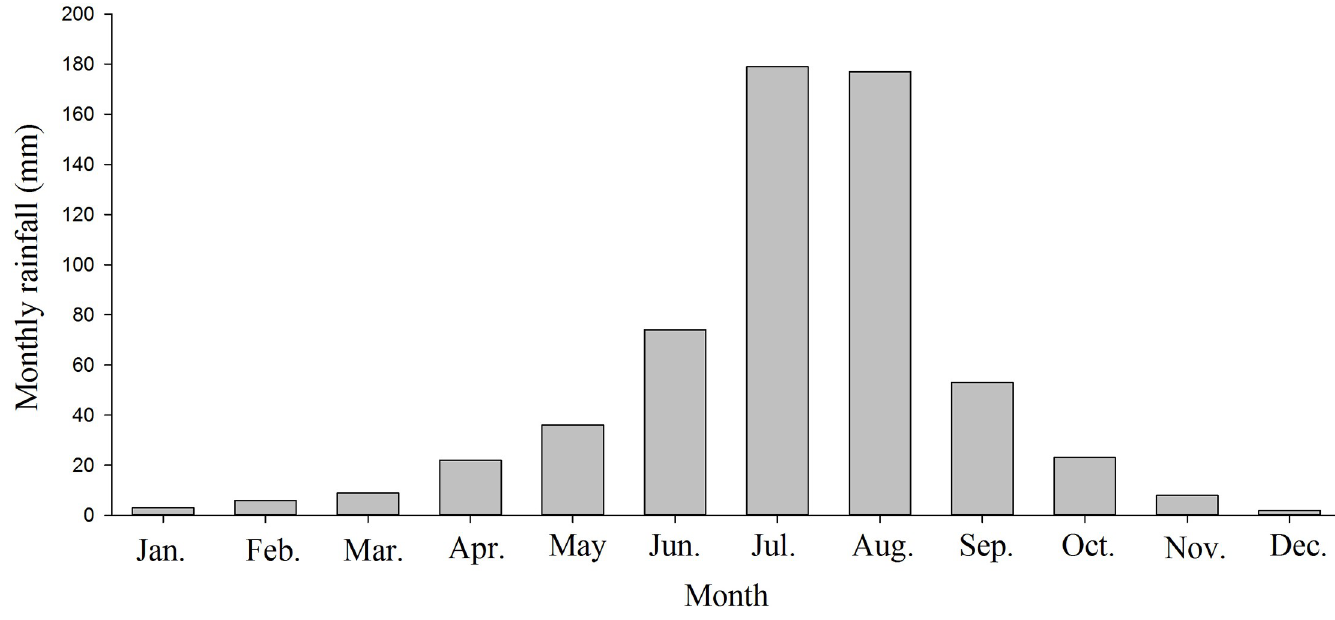
Fig 1. Monthly rainfall in Beijing,